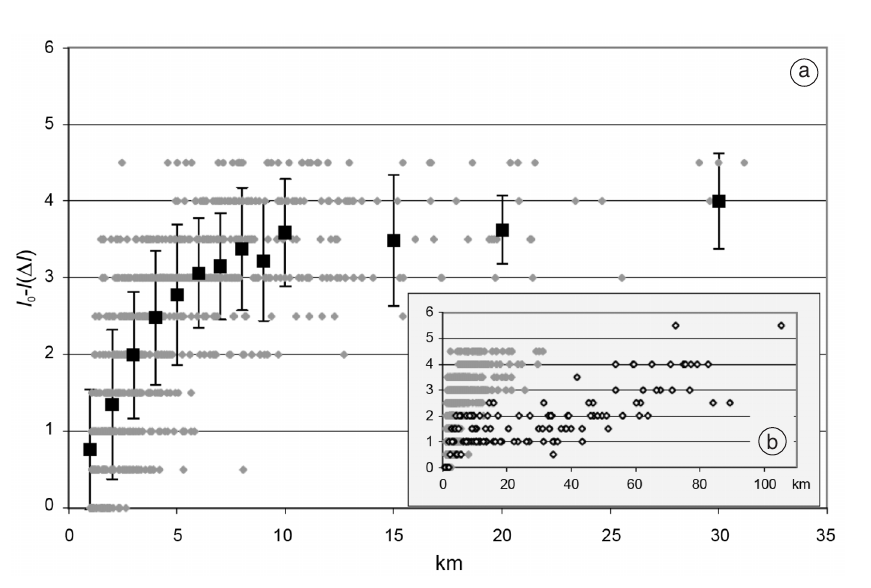
Fig. 7a,b. Etna area. a) Hypocentral distances versus ∆ I (difference between epicentral and site intensities) for the earthquakes used in the analysis (grey diamonds); black squares indicate the arithmetic average of ∆ I and